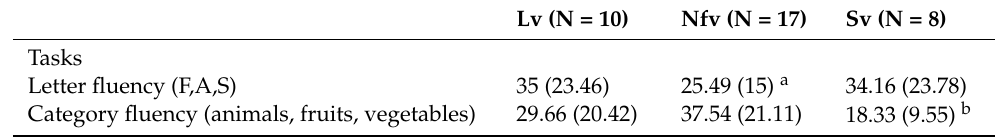
Table 2. Behavioral scores of letter fluency and category fluency (in percentage of correct responses with standard deviations in parentheses for both tasks) for all of the PPA patients and variants. Task differences: a = Nfv significantly impaired in letter compared to category fluency performance; b = Sv significantly impaired in semantic compared to letter fluency performance ( p ≤ 0.05 with Bonferroni Tukey post-hoc